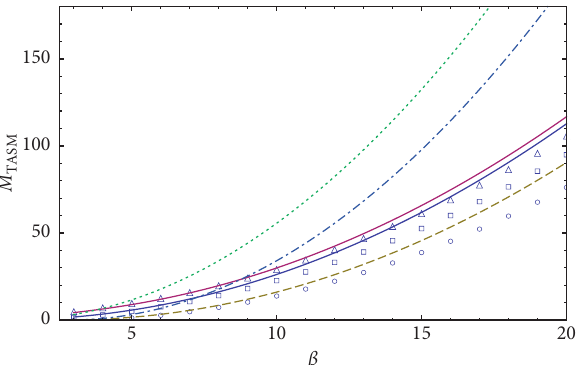
� 20 ( M � 5) in the case of F init init